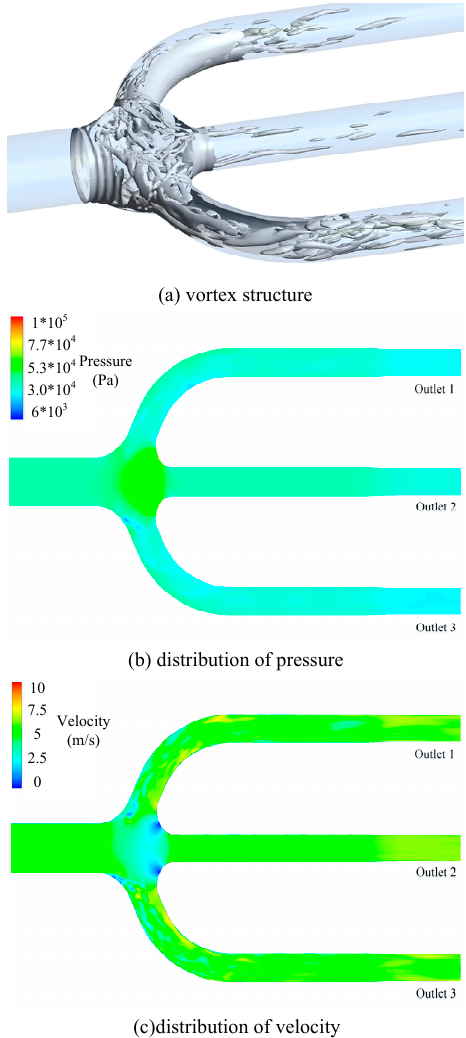
Figure 17. The flow pattern in the penstock: ( a ) the vortex structures; ( b ) distribution of pressure; ( c ) distribution of velocity (case 3).